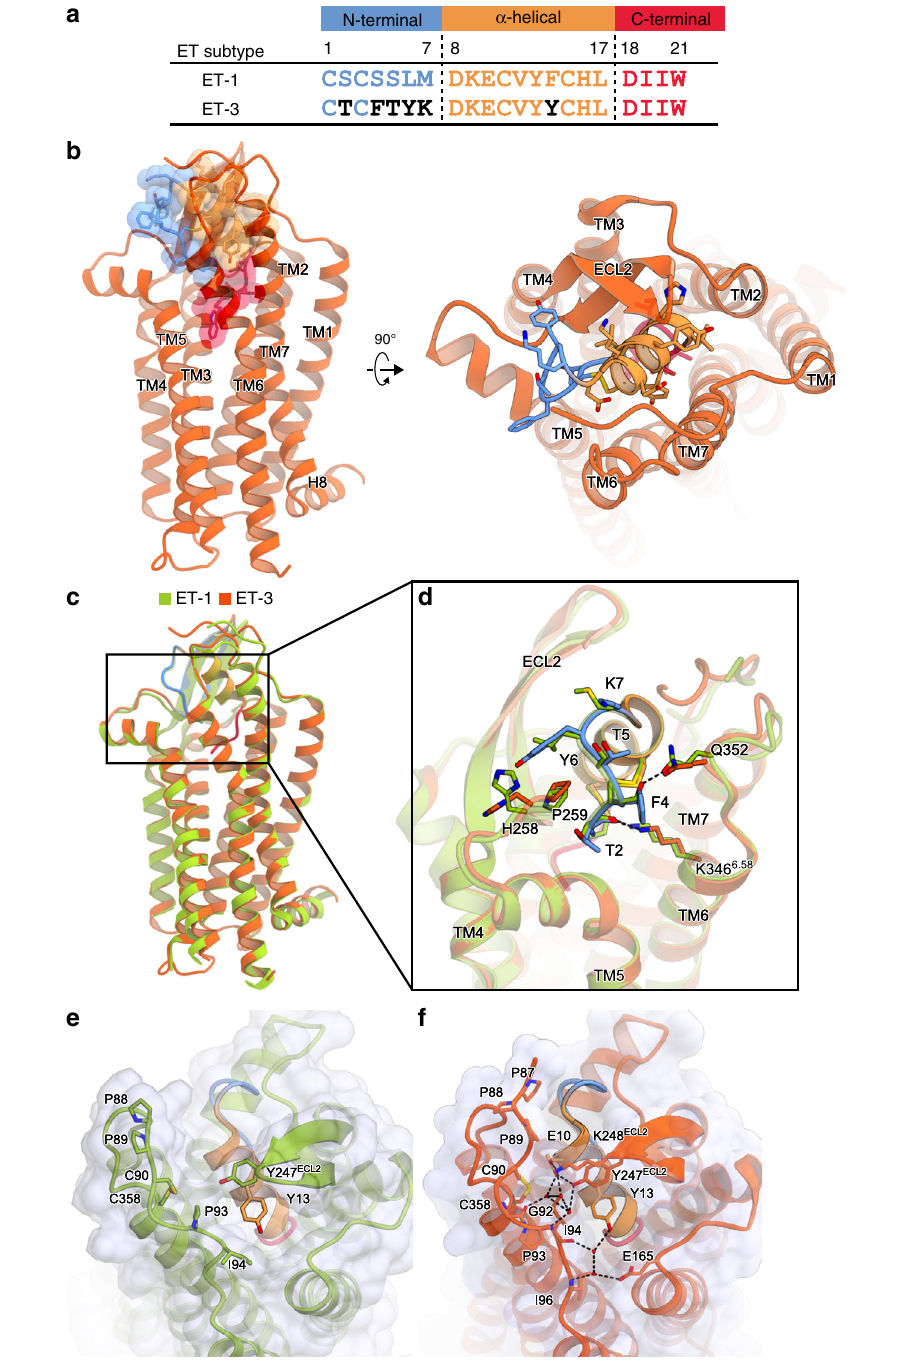
Fig. 2 ET B structure in complex with ET-3. a Comparison of the amino acid sequences of ET-1 and ET-3. b The overall structure of the ET-3-bound ET B receptor. The receptor is shown as an orange-red ribbon model. ET-3 is shown as a transparent surface representation and a ribbon model, with its N- terminal region coloured cyan, α -helical region orange, and C-terminal region deep pink. The side chains of ET-3 are shown as sticks. c , d Superimposition of the ET-3 and ET-1-bound ET B receptors, coloured orange-red and green, respectively, viewed from the membrane plane ( c ), and from the extracellular side ( d ). The side chains of ET-1 and ET-3 are shown as sticks. e , f Comparison of the interactions in the ET-1- ( e ) and ET-3- ( f ) bound structures. The receptors are shown as transparent surface representations and ribbon models. Endothelins are shown as ribbon models. The residues involved in the irreversible binding of the endothelins are shown as on the loop between the β -strand and TM5, but the ET A receptor in the ET B receptor (Fig. 4b). These observations suggest that has a truncated loop region and completely lacks these residues ECL2 adopts completely different structures between the ET A and ET B receptors. Moreover, ECL1 is also different between the two (Fig. 4a). In addition, the ET A receptor has a proline (P228) in the fi rst half of ECL2, which should disturb the β -strand formation as receptors, as the ET A receptor has a fi ve amino-acid elongation as